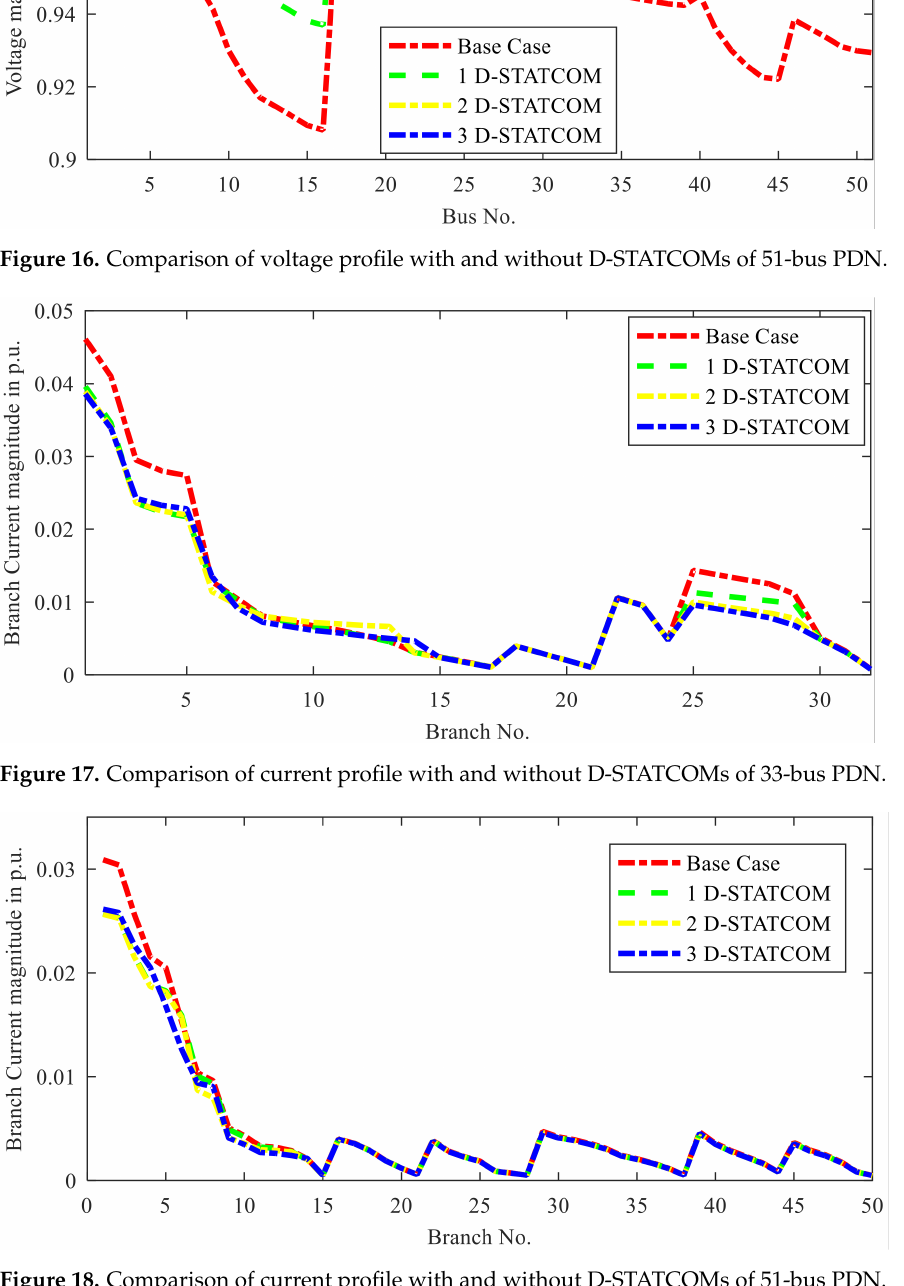
Figure 18. Comparison of current profile with and without D-STATCOMs of 51-bus